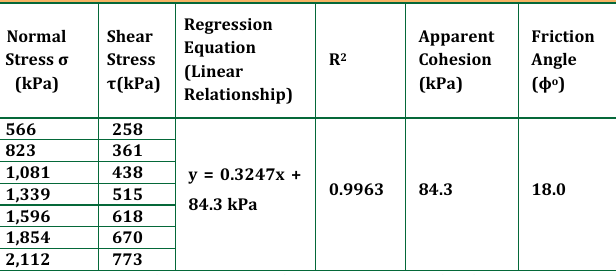
Table 2: Strength parameters of polished sandstone core from plots of normal stress versus shear stress (at 1-3 mm displacement).